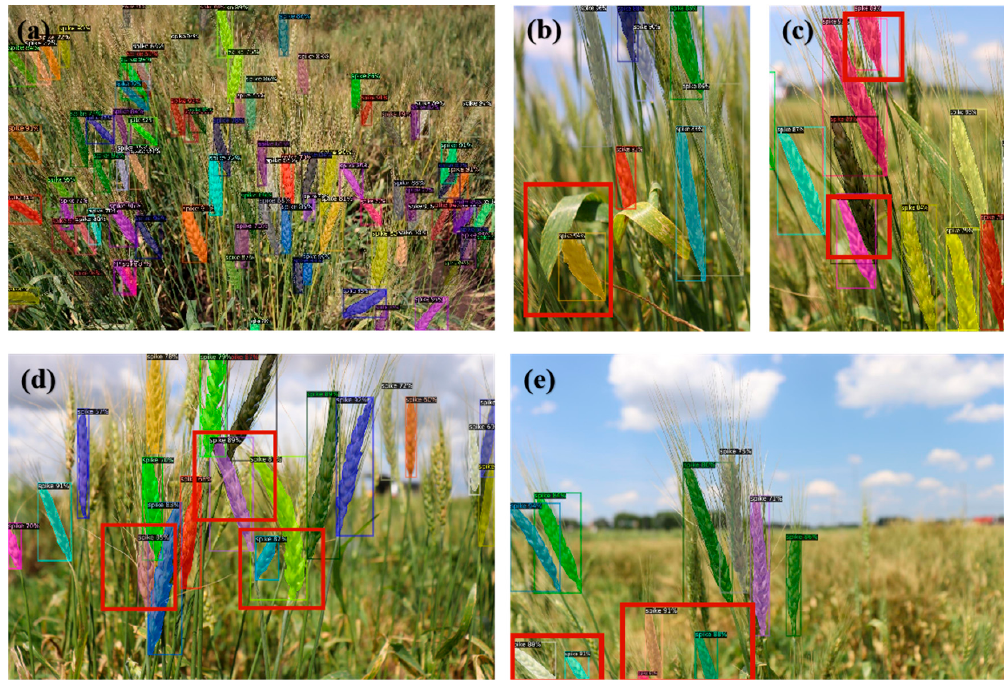
Figure 5. Successful segmentation results for wheat in five complex environments: ( a ) high-density wheat spikes in the field; ( b ) wheat spikes occluded by the leaves of other wheat; ( c ) wheat spikes occluded by other wheat awns or stems; ( d ) wheat spikes occluded by the other spikes; ( e ) wheat spikes cut at the image borders. (The red boxes are to emphasize different situations with complex backgrounds.)